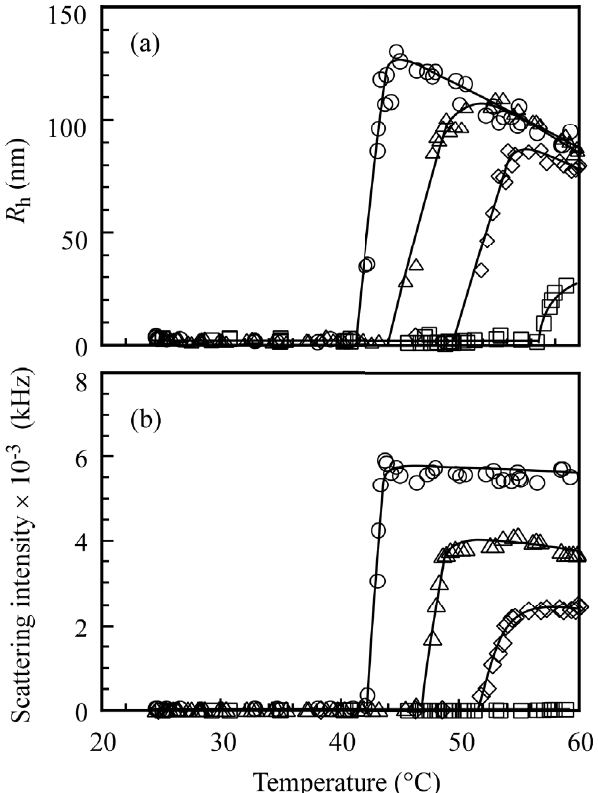
Figure 8. ( a ) Hydrodynamic radius ( R PMPC -PDEA ( △ ), PMPC 64 46 0.1 M NaCl as a function of